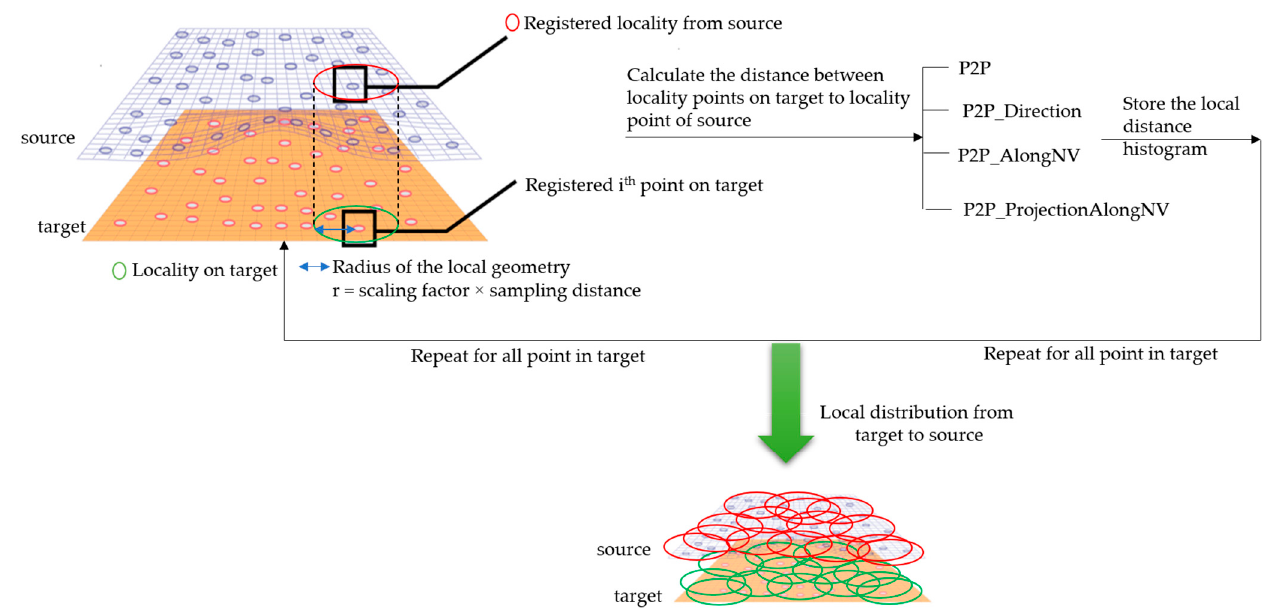
Figure 8. Sketch of the local neighborhood distance analysis.